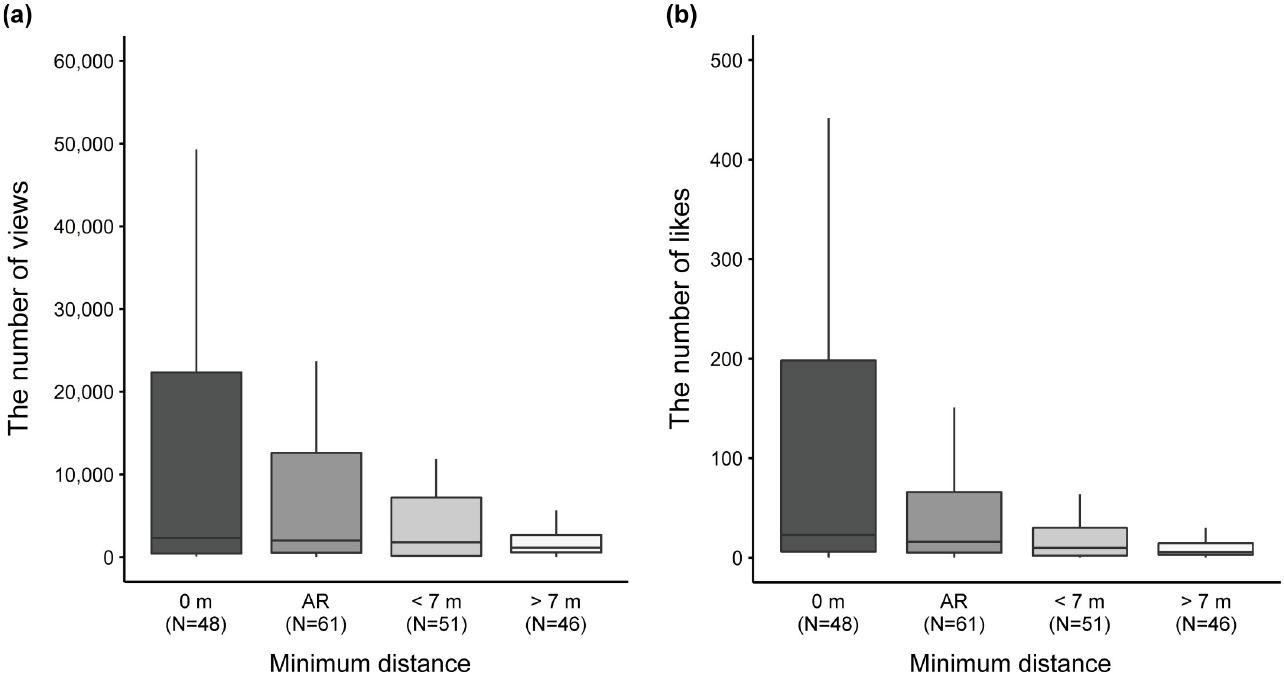
Fig 4. A comparison of the number of views and likes of the sampled YouTube videos related to mountain gorilla tourism (N = 206) between four different minimum distance categories (a, b). The upper and lower hinges of boxes represent the first and third quartiles and the thick lines in boxes show the medians. The upper whiskers extend out from boxes to the largest value no further than 1.5 � IQR from the hinges while the lower whiskers extend from the boxes to the smallest value no further than 1.5 � IQR of the hinges. As for the y-axis of each figure, only the parts under 60,000 (a), and 500 (b) are shown. AR means close proximity within arm’s